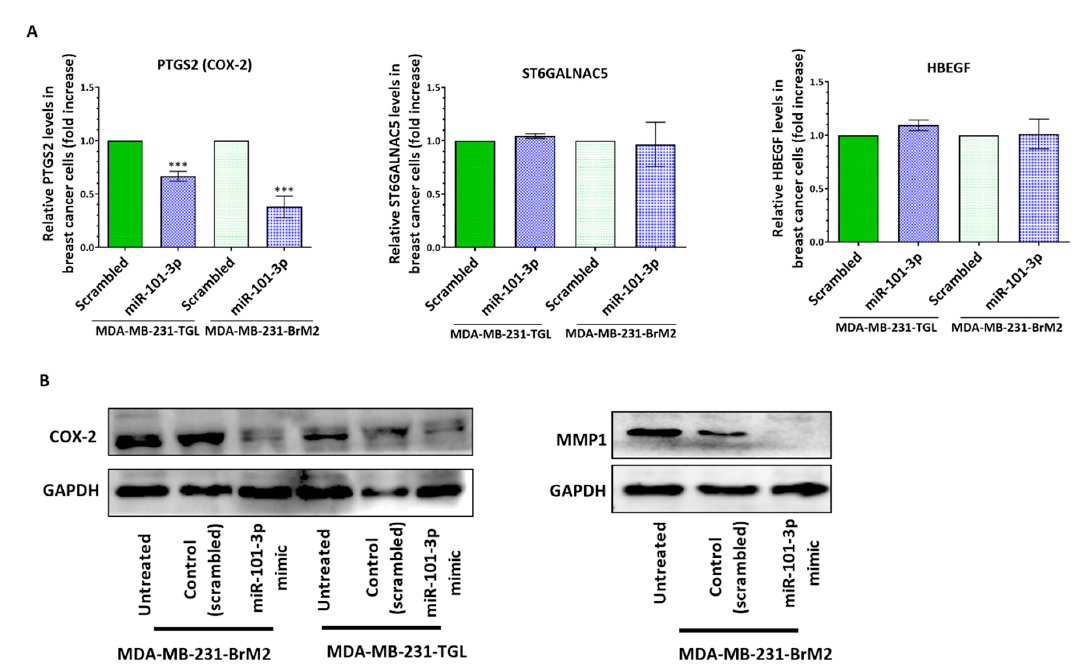
Figure 6. Ectopic upregulation of miR-101-3p in breast cancer cells attenuates their transmigration through the brain endothelium by reducing COX-2-MMP1 expression.MDA-MB-231-TGL and MDA-MB-231-BrM2 cells were transfected with miR-101-3p mimic (5 nM final concentration) or with scrambled control. ( A ) Relative PTGS2, ST6GALNAC5 and HBEGF mRNA measured by real time PCR in control and miR-101-3p mimic transfected cells. ( B ) Western Blot analysis of COX-2 and MMP1 in control and anti-miR-101-3p transfected MDA-MB-BrM2 cells. Data are mean ± SD from three independent experiments. *** p < 0.001.